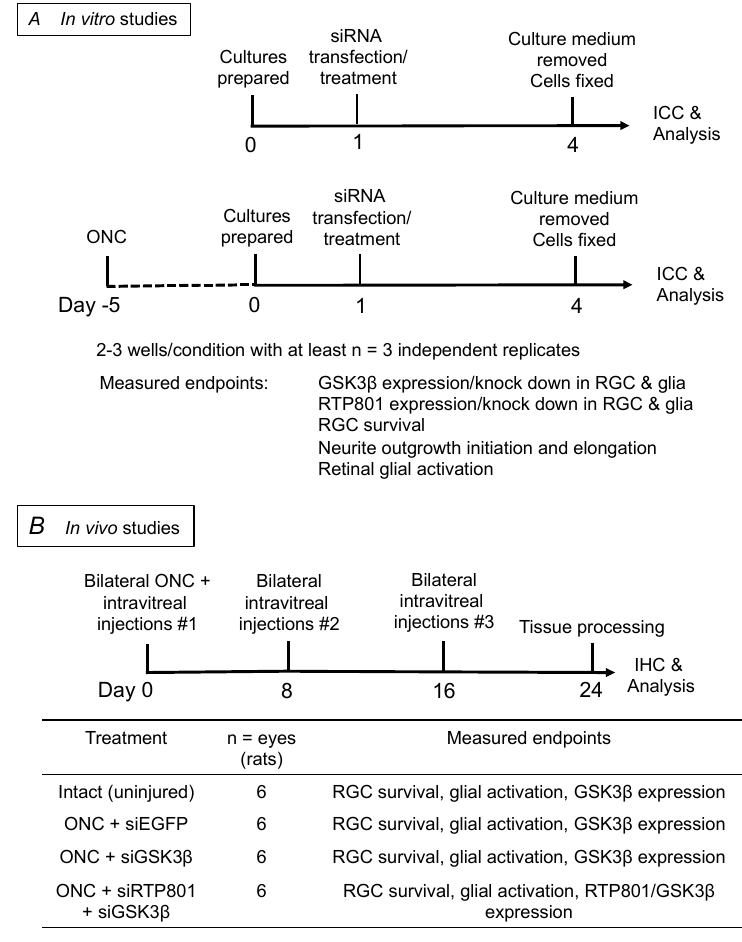
Figure 2. Schematic of the in vitro and in vivo studies, treatment paradigms, and their timelines. ( A ) experimental plan for in vitro studies; ( B ) experimental plan for in vivo studies.